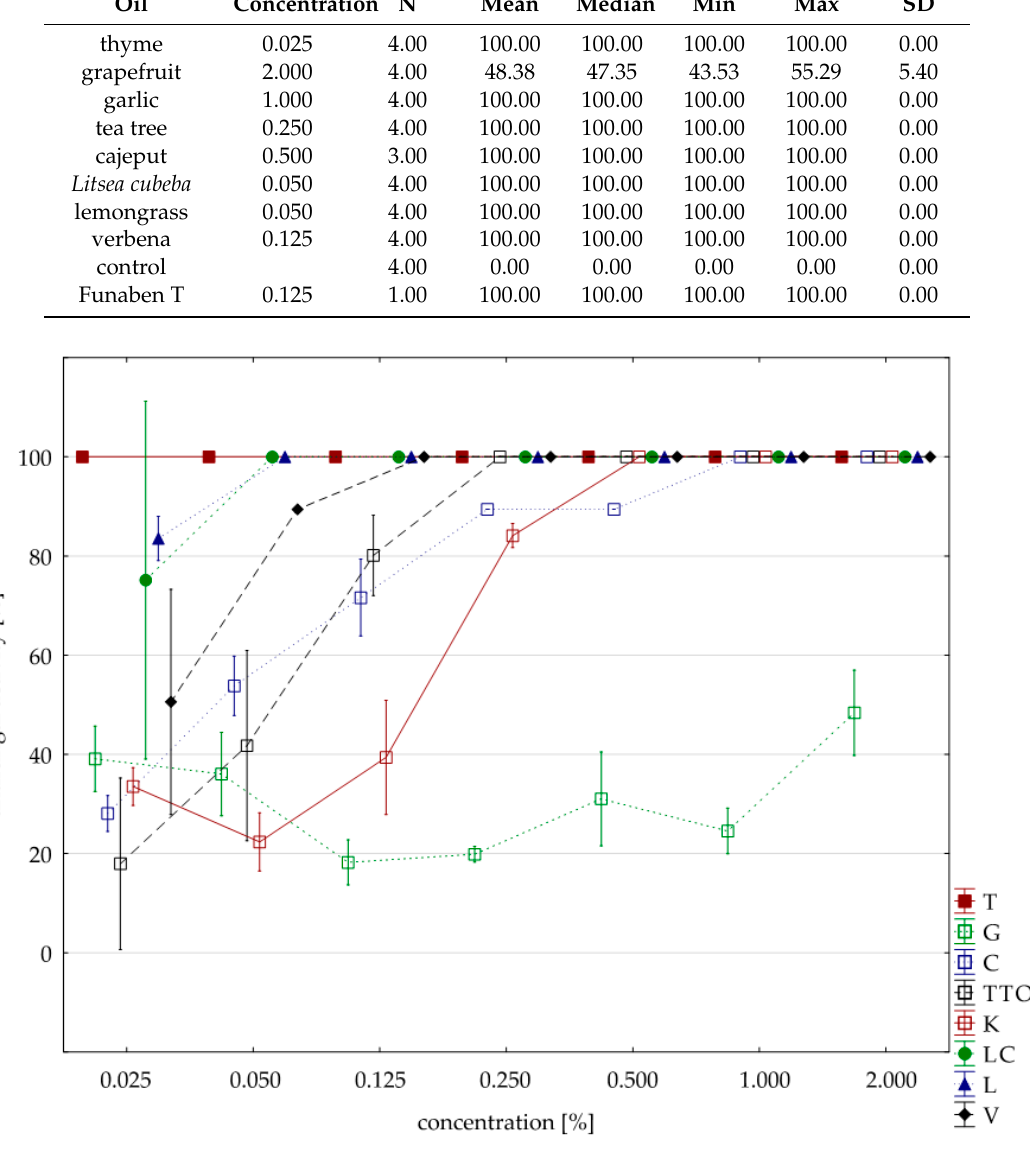
Figure 3. Plot of antifungal activity vs concentration for F . graminearum.